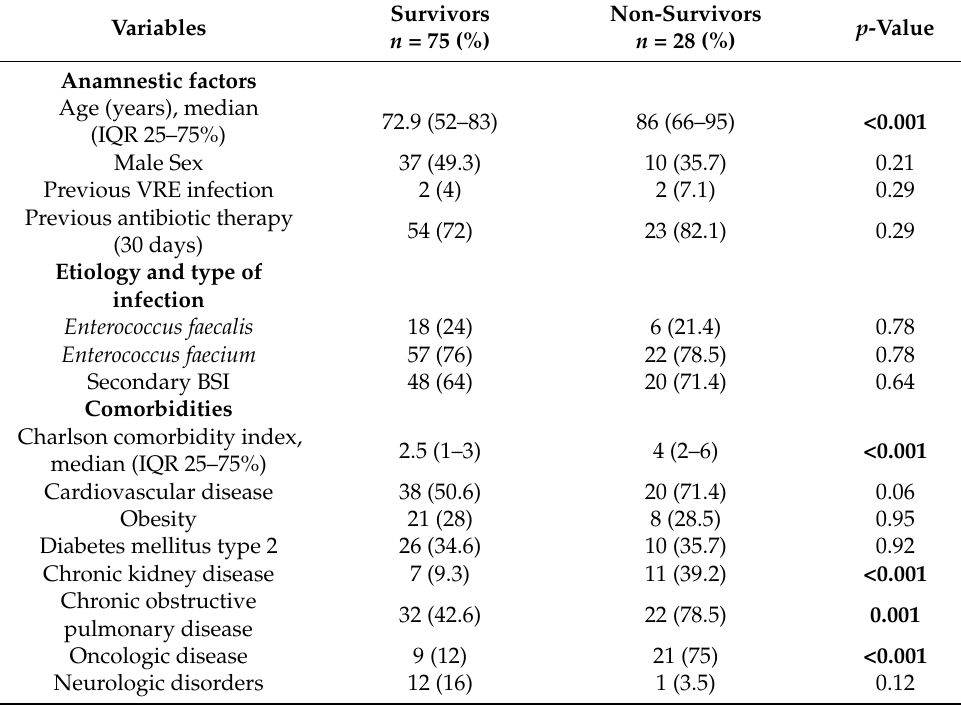
Table 2. Comparison between survivor and non-survivor